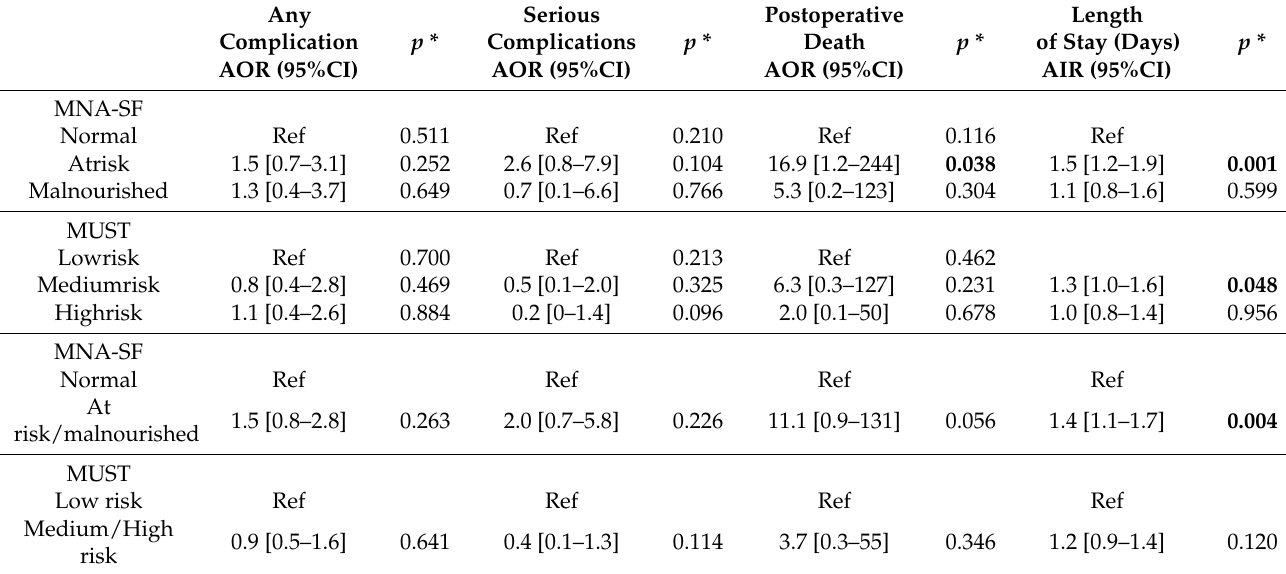
Table 3. Multivariate analysis of the association of MNA-SF and MUST tool with postoperative outcomes in 302 elderly patients undergoing operations of general surgery.